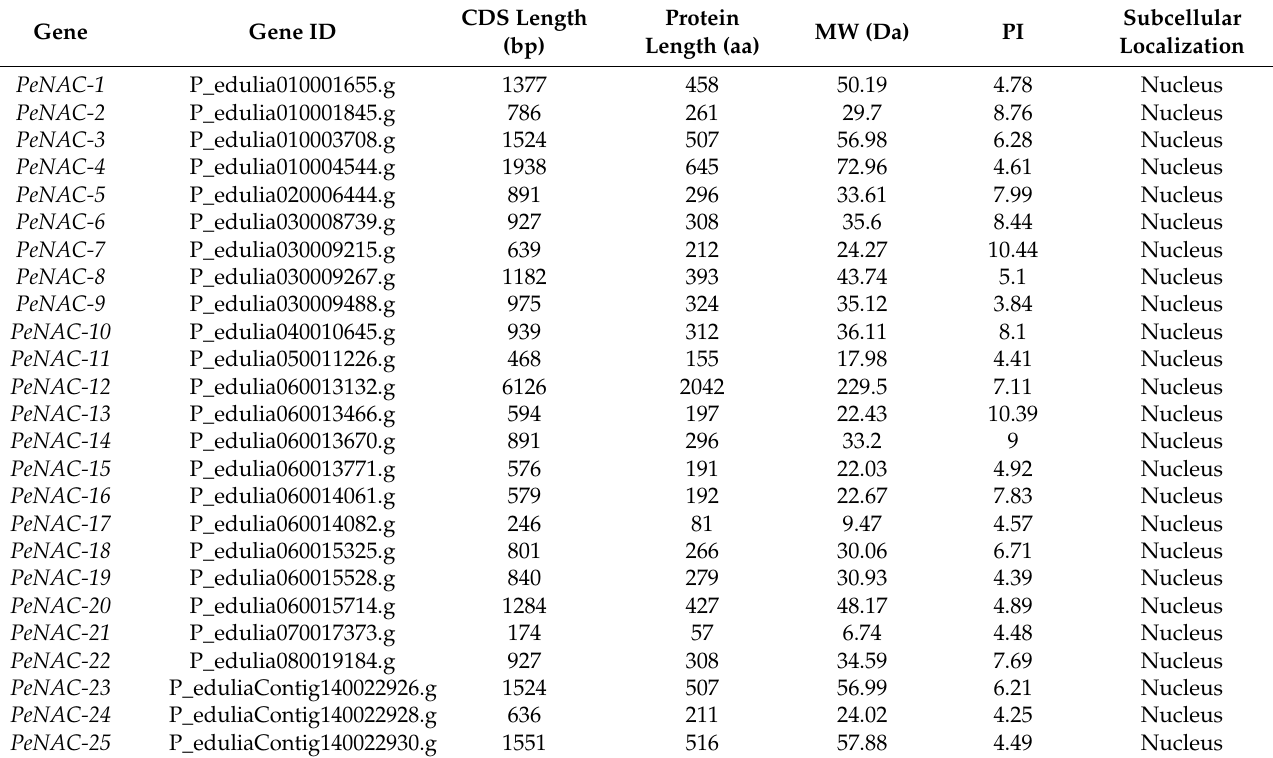
Table 1. Basic information of NAC genes identified in passion fruit. MW: molecular weight. PI: isoelectric